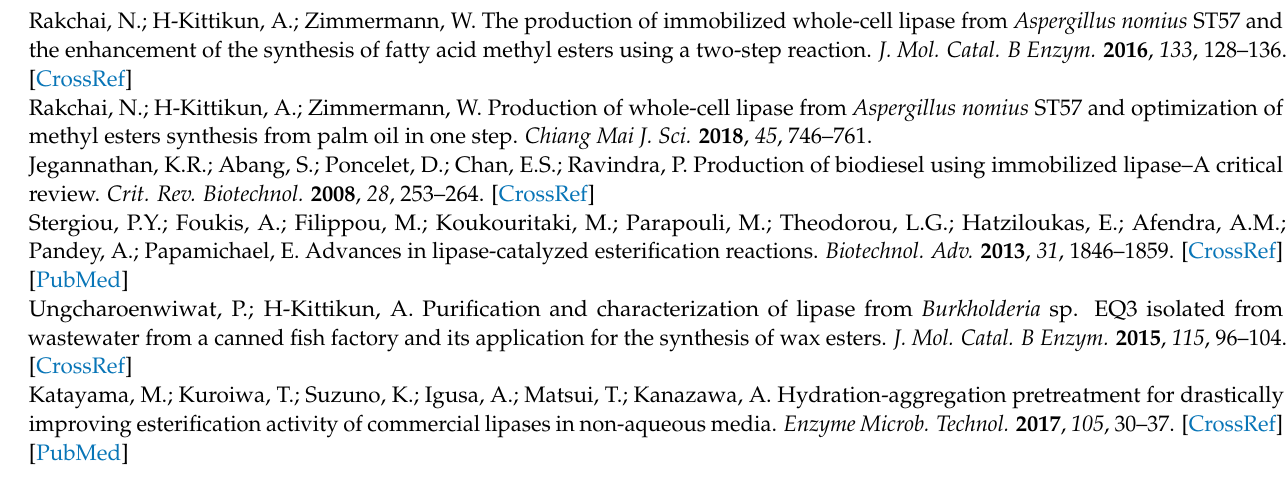
produced biodiesel, Table S2: ANOVA for response surface of fatty acid methyl esters synthesis, Figure S1: Hydrolytic activities of whole-cell lipase produced by different fungal strain cultured in decanter cake waste-based media. (Five isolates including RT20, ST5, ST45, ST49 and ST52 were Rhizopus spp. while isolate RT24, RT29, MS15, MS26 and ST52 were Aspergillus spp.), Figure S2: Hydrolytic, transesterification and esterification activities of whole-cell lipase produced by the selected fungal Aspergillus sp. MS15 cultured in decanter cake waste-based media (DCM1) containing different carbon sources, Figure S3: Hydrolytic, transesterification and esterification activities of whole-cell lipase produced by the selected fungal Aspergillus sp. MS15 cultured in decanter cake waste-based media (DCM1) containing different nitrogen sources, Figure S4: Three-dimensional contour plots showing the effect of A: moisture content (%), B: pH, C: temperature ( ◦ C) on fatty acid methyl esters (FAME; %) synthesized by esterification. One variable kept constant at its center point and other two variables varied within the experimental range, Figure S5: Three-dimensional contour plots showing the effect of A: moisture content (%), B: pH, C: temperature ( ◦ C) on fatty acid methyl esters (FAME; %) synthesized by transesterification. One variable kept constant at its center point and other two variables varied within the experimental range, Figure S6: TLC/FID chromatogram of standard